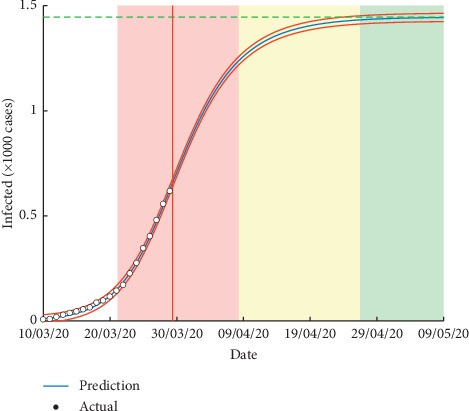
Presentation of the evolution of total infected cases (R0 = 2.003, β = 0.499, γ = 0.249, N = 1,812, Cend = 1,446, Send = 366, RMSE = 7).